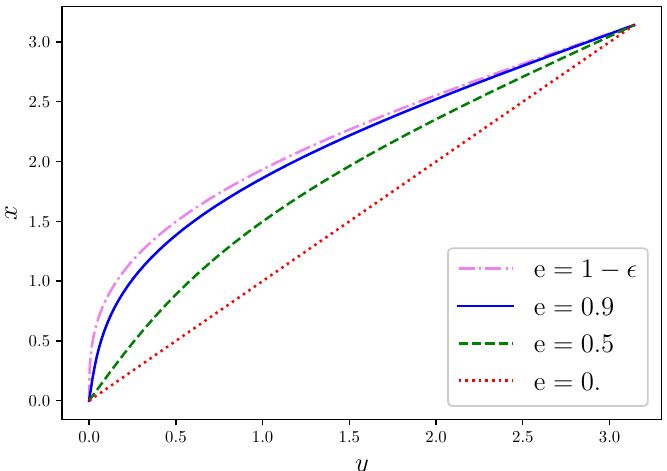
Figure 1. Solution x = f − 1 ( y ) of Kepler’s equation for different values of the eccentricity ( (cid:101) = 2.22 10 − 16 ). ×